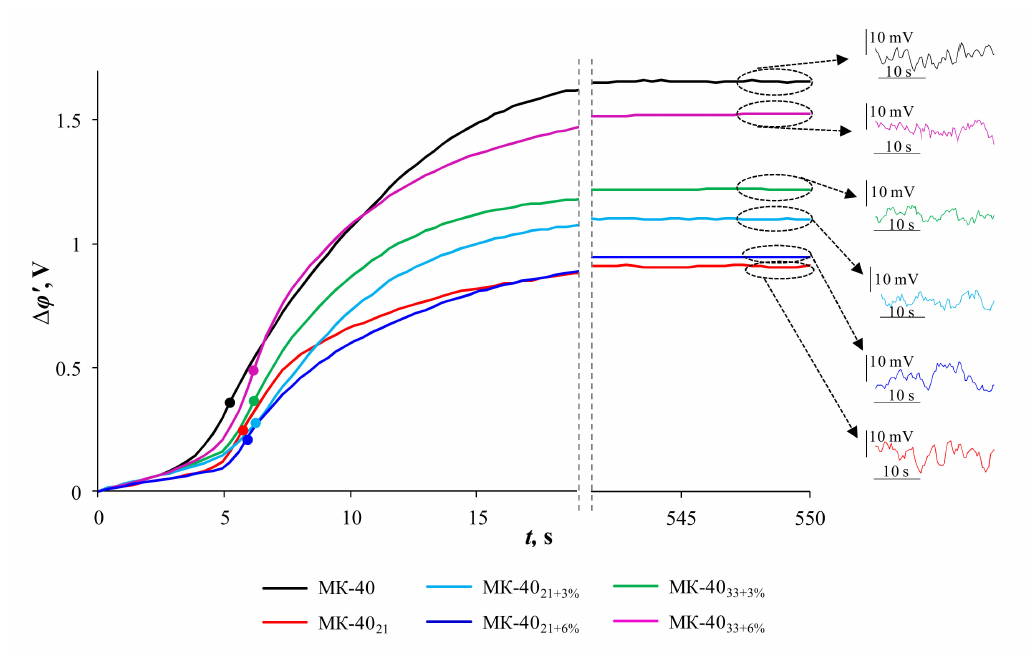
= 2. The circles lim